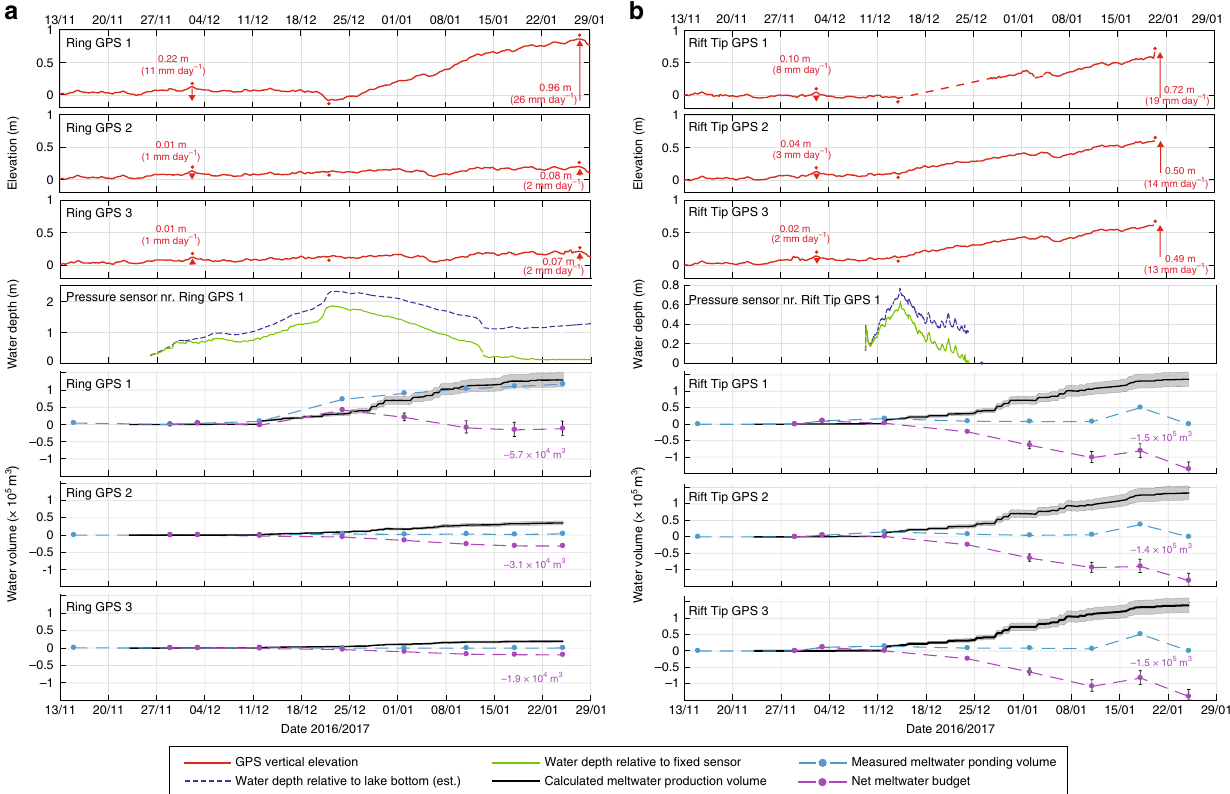
Fig. 3 Vertical ice shelf displacement with water depths and seasonal meltwater budgets for Ring and Rift Tip lake sites. a is for Ring, and b is for Rift Tip. For each site, the top three plots show the vertical ice-shelf displacement (relative to arbitrary elevation) from three GPS stations (Fig. 1b, red stars). The fi rst red dot above each time series shows when GPS 1 reaches its highest elevation, before reaching its lowest elevation, shown by a second red dot. The third red dot indicates when GPS 1 reaches its highest elevation during the whole time period. Numbers next to red arrows (which depict the direction of movement) are the total vertical de fl ections, and de fl ection rates, measured by each GPS over the two respective time periods between the fi rst and second red dots, and the second and third red dots. Some of the elevation data for Rift Tip GPS 1 are missing so are linearly interpolated (dashed-red line). The fourth plot for each lake site shows water depth data from the pressure sensor nearest to each GPS 1 (Fig. 1b, green open circles). Water depths relative to lake bottom were estimated from sensors fi xed at constant heights (see Methods). The bottom three plots at each site show the calculated seasonal meltwater budgets around each GPS station. The black lines (and grey shading) show cumulative volumes (and errors) of meltwater production calculated by a PDD model; light blue dots show the measured volumes of meltwater ponding from 9 cloud-free Landsat 8 images (see Supplementary Table 2 for image dates), and the dashed-light blue lines show these data linearly interpolated between the image dates; purple dots (and whiskers) show the net meltwater budget (and errors) on each image date, and the dashed-purple lines show these data linearly interpolated between the dates. Purple numbers next to the net meltwater budget plots refer to the seasonal net meltwater budgets, each de fi ned as the maximum minus minimum net meltwater budget during the melt season, which are all negative. See Methods for details of GPS and water-depth data processing, and meltwater budget and